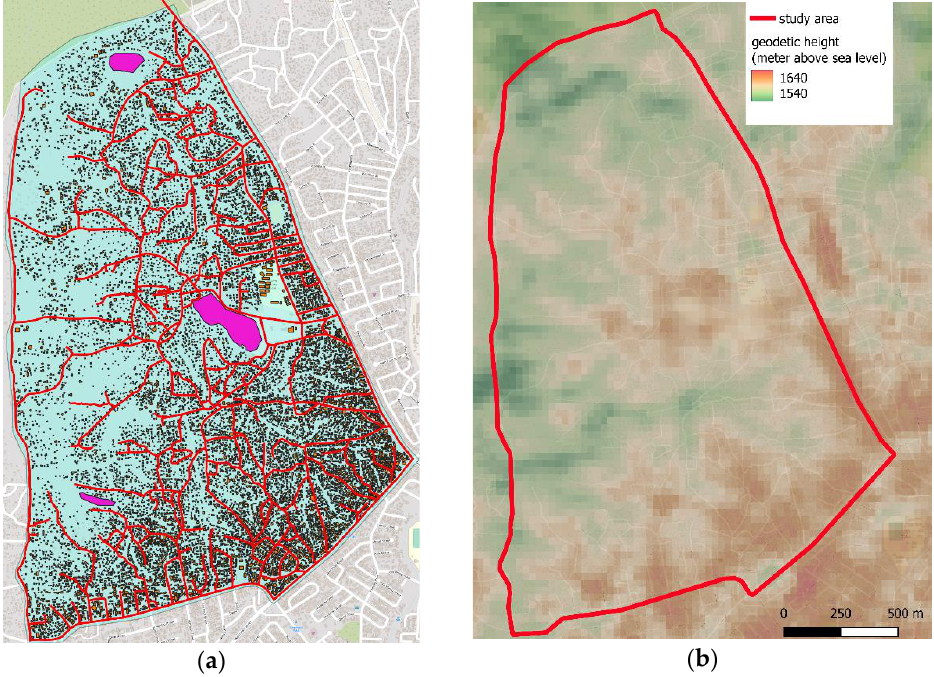
Figure 2. Study area as well as input data ( a ) (source map/shacks/roads: [47]); DEM map of the study area ( b ) (data: [48]).